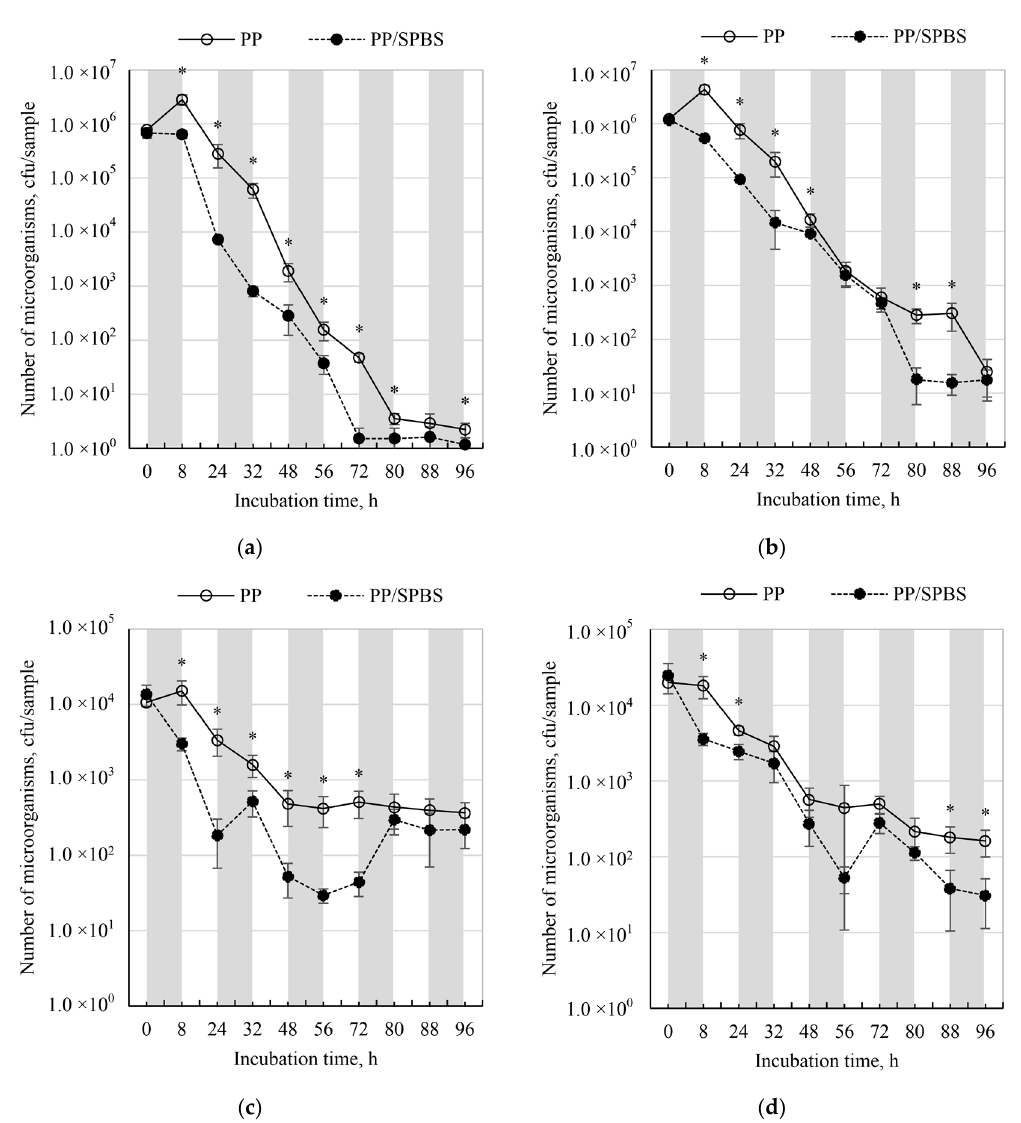
Figure 2. Number of microorganisms on control and bioactive nonwovens during incubation simulating 5 days of use in plant biomass processing workstations: ( a ) E. coli ; ( b ) P. fluorescens ; ( c ) A. niger ; ( d ) P. chrysogenum . *—Significant differences between the number of microorganisms on the PP and PP/SPBS nonwovens (one-way ANOVA, p < 0.05; Tukey’s test, p < 0.05). A. niger number on PP nonwoven reduced from 1.52 × 10 4 cfu/sample (after 8 h incubation) to 3.67 × 10 2 cfu/sample (after 96 h incubation). On PP/SPBS nonwoven, A. niger number reduced